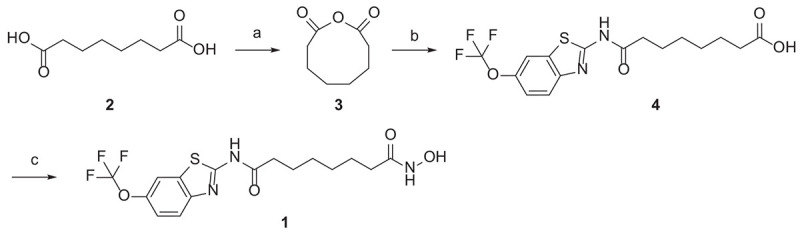
Reagents and conditions: (a) acetic anhydride, reflux; (b) riluzole, THF, reflux; (c) ClCOOi-Bu, TEA, NH2OH.HCl, THF, r.t.